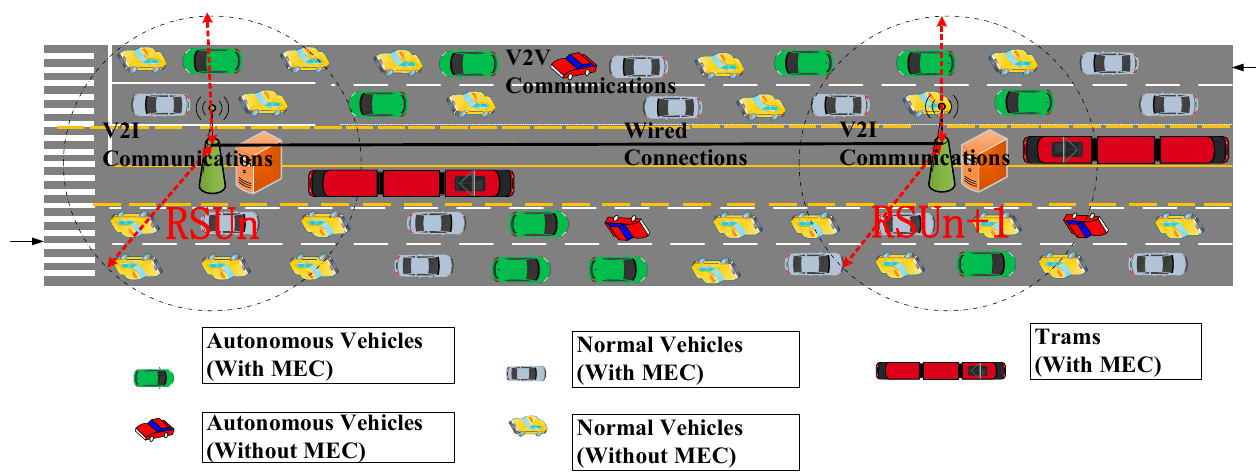
Figure 1. Vehicle communication demands of the mixed traffic flow.